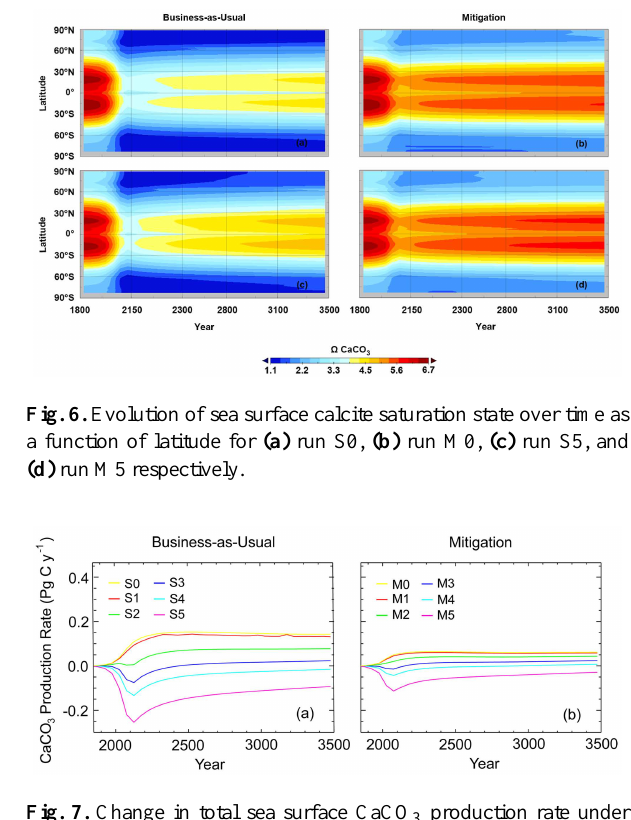
Fig. 7. Change in total sea surface CaCO 3 production rate under (a) a “business-as-usual” CO 2 emissions scenario (Suite S) and (b) under a “mitigation” CO 2 emissions scenario (Suite M).